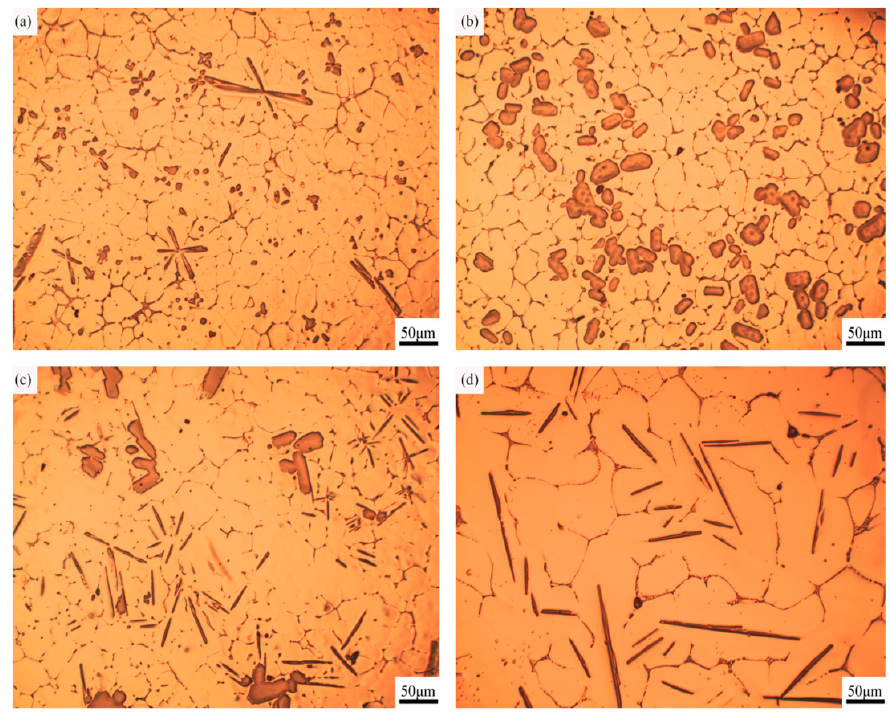
Figure 2. Optical micrographs of Al–4Ti master alloys at different cooling rates: ( a ) 3.36 K/s; ( b ) 2.57 K/s; ( c ) 1.65 K/s; ( d ) 0.31 K/s.